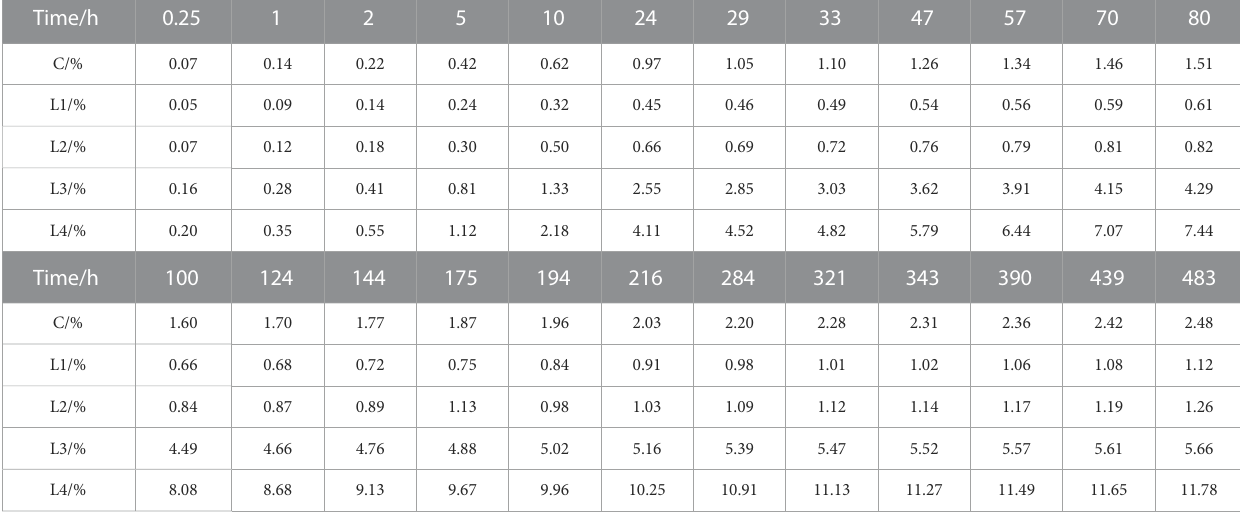
TABLE 4 Water absorption rate of cement – lithium slag mortar at 28